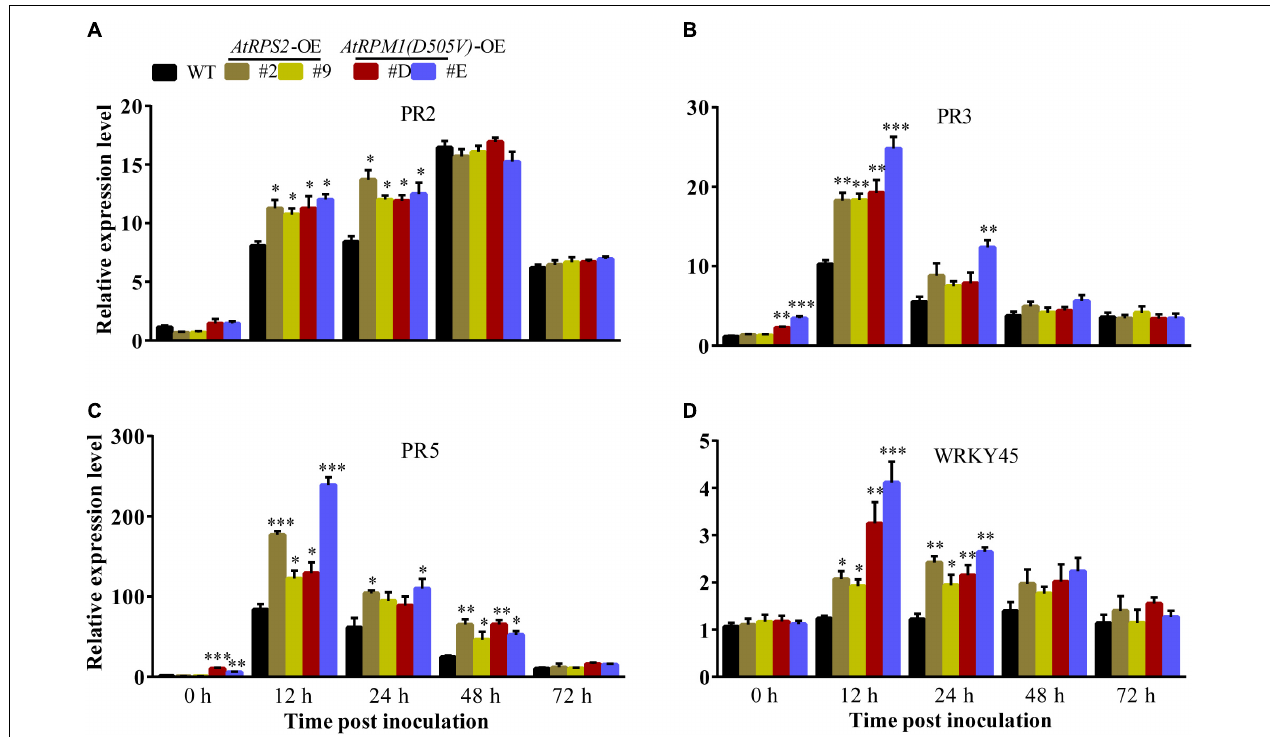
FIGURE 6 | Overexpression of AtRPS2 and AtRPM1 ( D505V ) Trigger the Expression of Defense Responsive Genes in Transgenic Rice. (A–D) AtRPS 2 and AtRPM1 ( D505V ) promoted the expression of rice defense-responsive genes after inoculating M. oryzae isolate GC1-4; the OsActin gene was used as an internal control. Gene expression levels were normalized to 0 h of Nipponbare. Data are shown as means ± SD ( n = 3). Asterisks denote significant differences (one way ANOVA, ∗ P < 0.05, ∗∗ P < 0.01, ∗∗∗ P < 0.001). Similar results were obtained in three independent